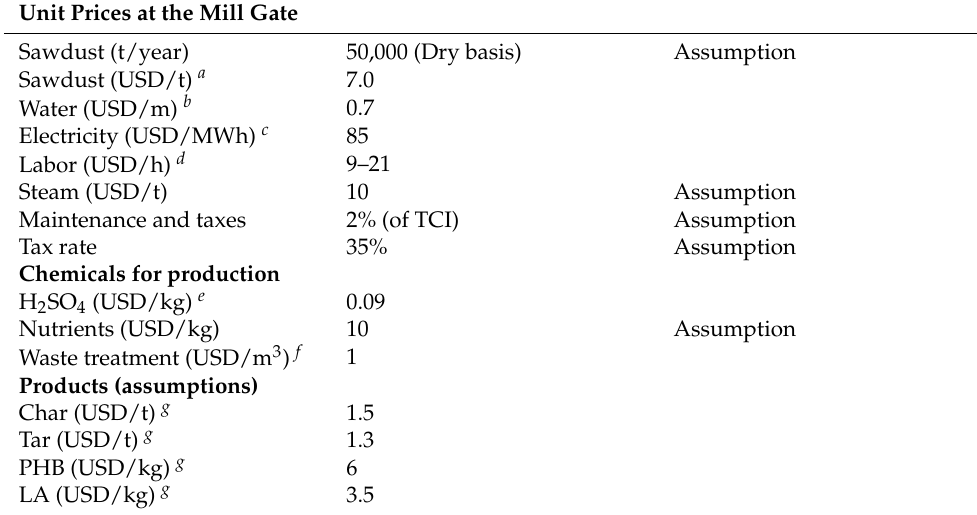
Table 3. Unit values of variables used in the techno–economic assessment. Unit Prices at the Mill